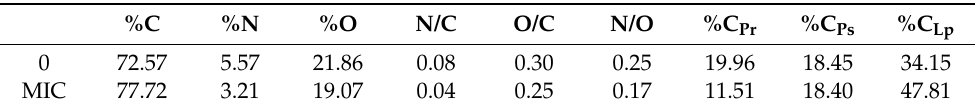
Table 1. Surface chemical composition measured by XPS of mycelia treated with paeonol at 0 and